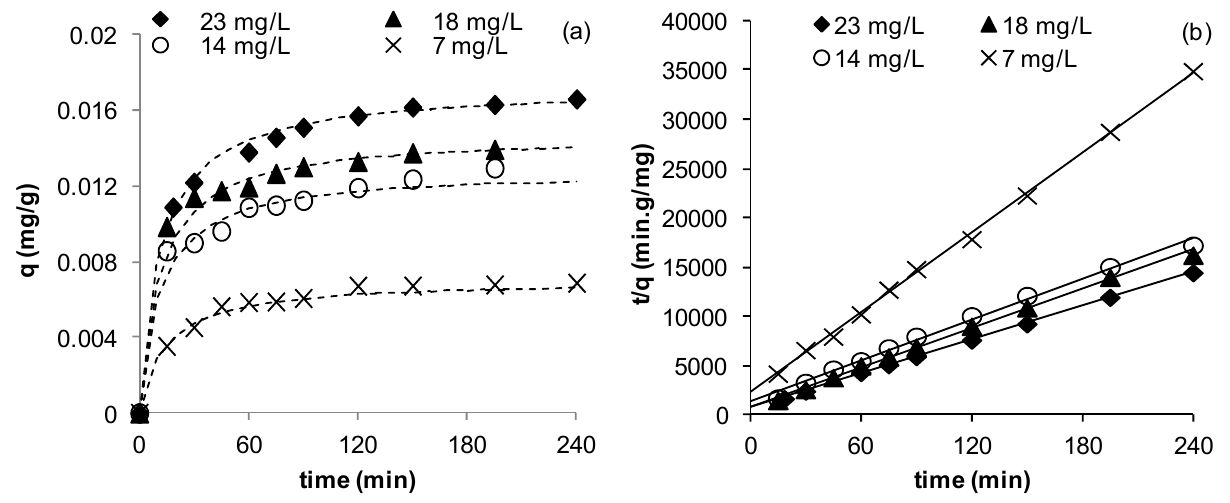
Figure 2. Kinetics of Cu ions adsorption on MCS at different initial copper concentrations ( a ) experimental data, dashed lines represent the pseudo second-order model; ( b ) linearized pseudo second-order model ( γ = 0.0709 mg Mn/g sand, m = 50 g, V = 50 mL, Mn sand solution pH = 5, shaker speed = 150 rpm, T = 25.6